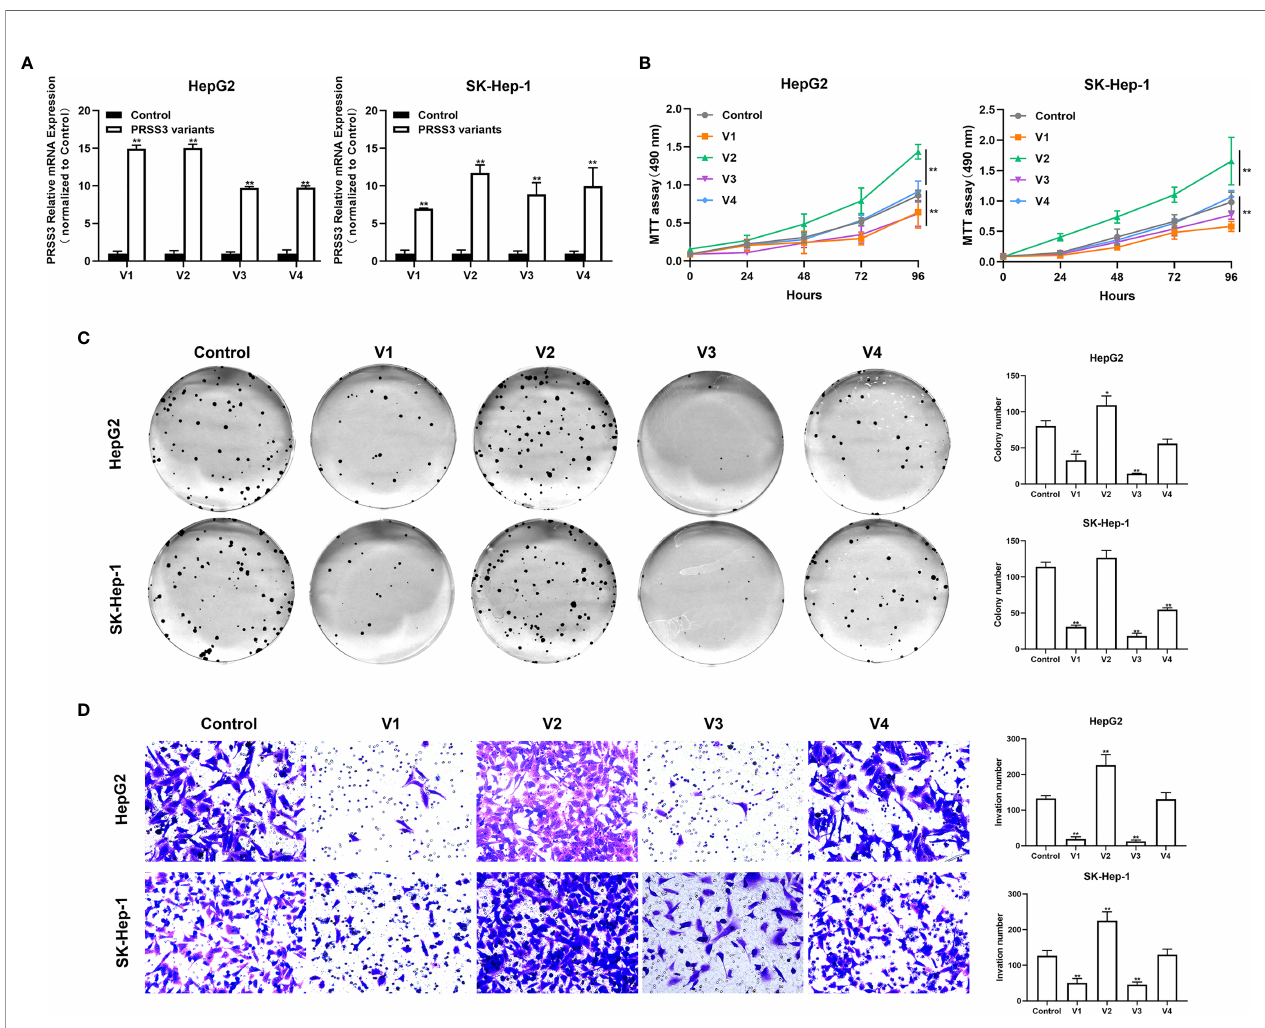
FIGURE 4 | Effects of ectopically expressed PRSS3 transcripts on HCC cell malignancy. The PRSS3 splicing variants were separately transfected into HepG2 and SK-Hep-1 cells to establish stable cell lines with individual overexpression of either PRSS3-V1 to -V4 ( V1 to V4 ) or vector control (Control). (A) The mRNA expression levels of PRSS3 transcripts in the transfected cells were measured by RT – qPCR and quanti fi ed relative to the control cells (Student ’ s t test). (B) Cell viability of HepG2 and SK-Hep-1 cells with ectopic expression of either PRSS3 transcript was detected by MTT assays compared with the vector control (two ‐ tailed Student ’ s t ‐ test). (C) Colony assays showing the colony formation of HepG2 and SK-Hep-1 cells after overgrowing for 2 weeks. Representative images are presented in the left panel; quantitation of the colony numbers is shown on the right. (D) Transwell invasion assay assessing cell invasion capacity following transfection of PRSS3 transcripts. Left panel: representative image at 200× magni fi cation; right panel: quantitation of the migrated cells. One − way ANOVA with Tukey ’ s post-hoc test was calculated for the transfected cells compared with the vector control in (C, D) . * P < 0.05, ** P < 0.01, versus control. Data are presented as the mean ± SD of three independent experiments performed in